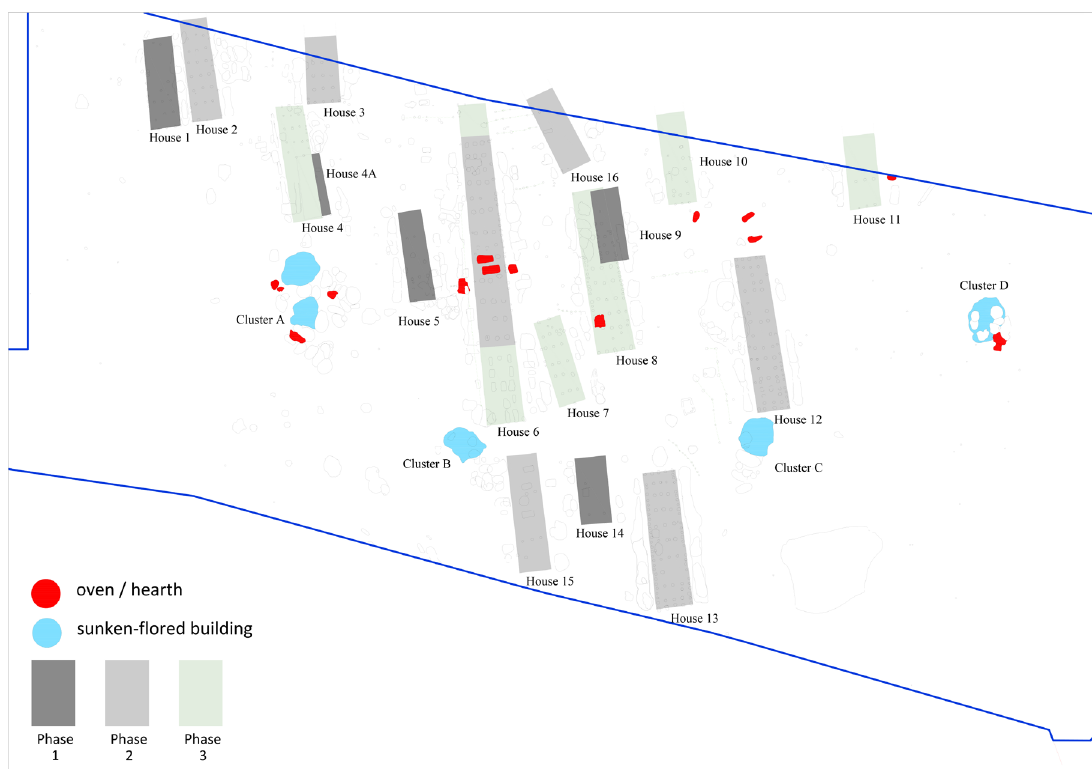
Figure 4: Plan of Brzezie site